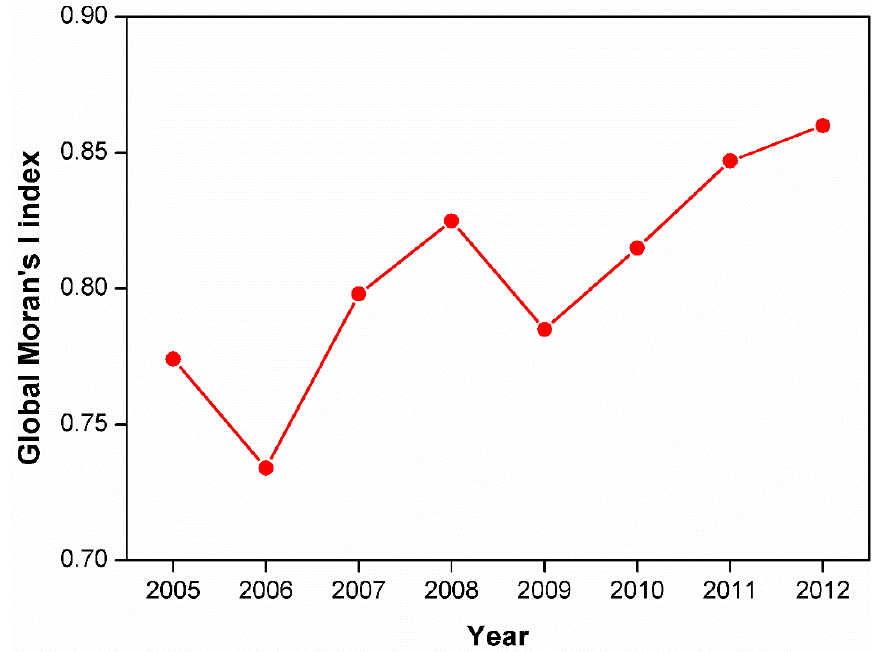
Figure 1. Spatial distribution of annual mean tropospheric NO 2 over China in 2006, 2008, 2010 and 2012.